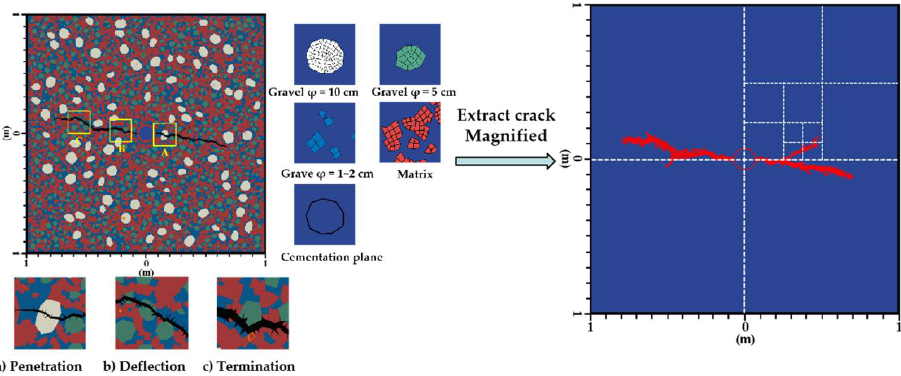
Figure 3. Numerical simulation of conglomerate fracture network